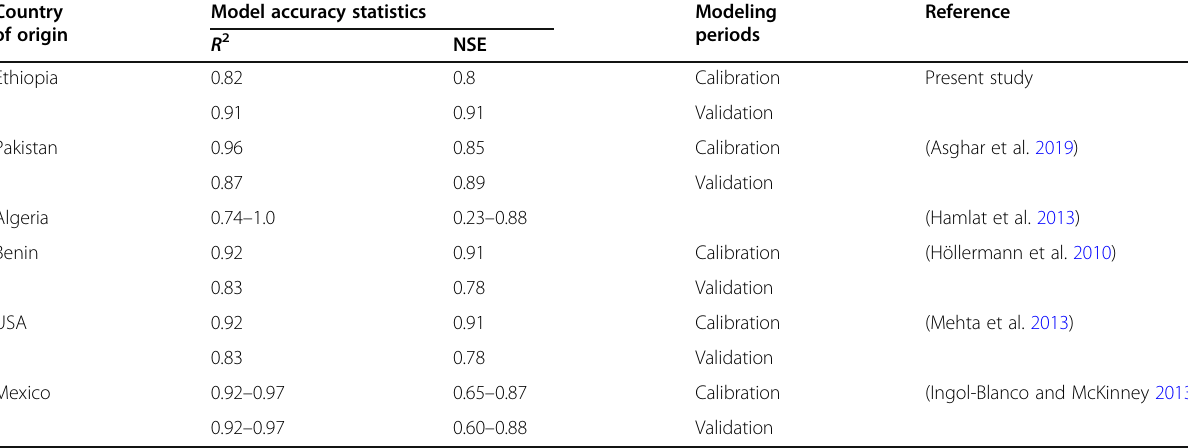
Table 5 Comparison of WEAP hydrologic model performance evaluation with other similar studies elsewhere Country of